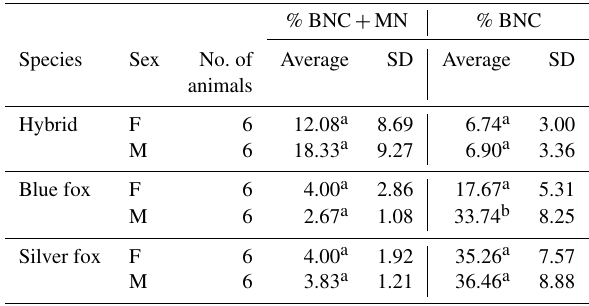
Table 2. Comparison of males and females in the MN test % BNC + MN %